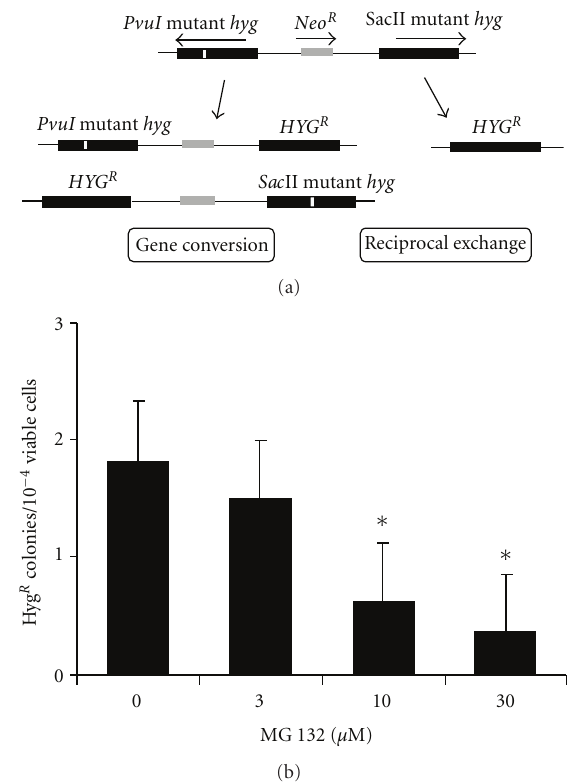
Figure 1: The proteasome inhibitor MG132 decreases HR in HeLa cells. (a) HR substrate in HeLaG1 cells. HeLaG1 cells contain an intrachromosomal recombination substrate consisting of two hygromycin resistance ( hyg R ) alleles inactivated by the insertion of 10bp and separated by the Neo R that confers resistance to G418. One hyg R allele is inactivated at the PvuI site, whereas the other one is inactivated at the SacII site. An intrachromosomalrecombination event leads to the reversion to hygromycin resistance phenotype ( HYG R ) by gene conversion or reciprocal exchange. (b) MG132 reduces HR in HeLa cells. Cells were seeded in a 6-well plate at the concentration of 2 × 10 5 per well. After 24 h cells were incubated for 5 hours with 0.3% DMSO as control or with 3 μ M, 10 μ M, and 30 μ M MG132. Next, cells were trypsinized, counted, and seeded as described in Material and Methods. After 24 hours, hygromycin (200 μ g/mL) was added. After 10 days, when the clones were visible, plates were stained with crystal violet and hygromycin- resistant clones were counted. The frequency of HR was calculated by dividing the total number of HYG R colonies by the number of viable cells. Data are reported as mean of five independent experiments ± standard deviation. Results are statistically analyzed using Student’s t -test. ∗ P < .